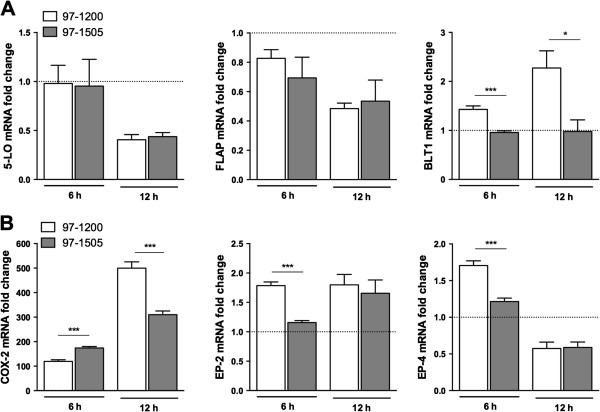
Differential mRNA expression of COX-2 and PGE2/LTB4 receptors induced by Mtb isolates 97-1200 and 97-1505. mRNA expression of (A) 5-LO, FLAP, and BLT1, and (B) COX-2, EP-2, and EP-4 in alveolar macrophages infected for 6 and 12 h with Mtb isolates 97-1200 and 97-1505. Dotted lines show the relative expression of uninfected cells (fold change = 1). All samples were normalised by Gapdh endongenous control. ***P < 0.0001; *P < 0.05 (one-way ANOVA). Data are representative of two independent experiments (error bars, s.e.m.).